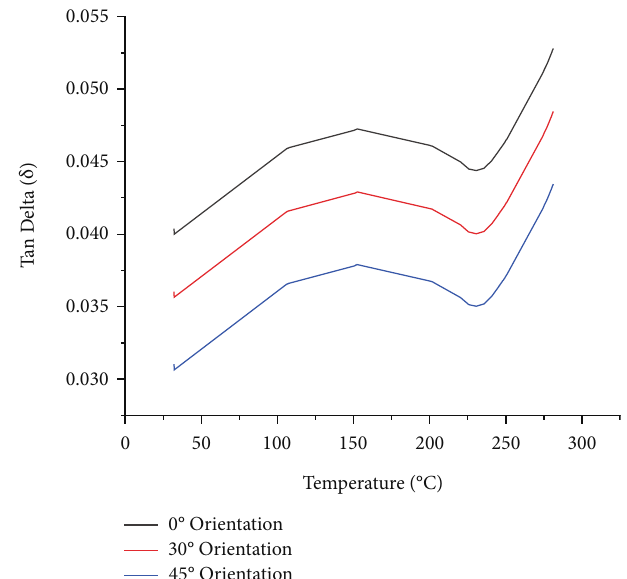
Figure 4: Temperature versus tan δ of the basalt fi ber reinforced with anamide composites at di ff erent orientations and a frequency of